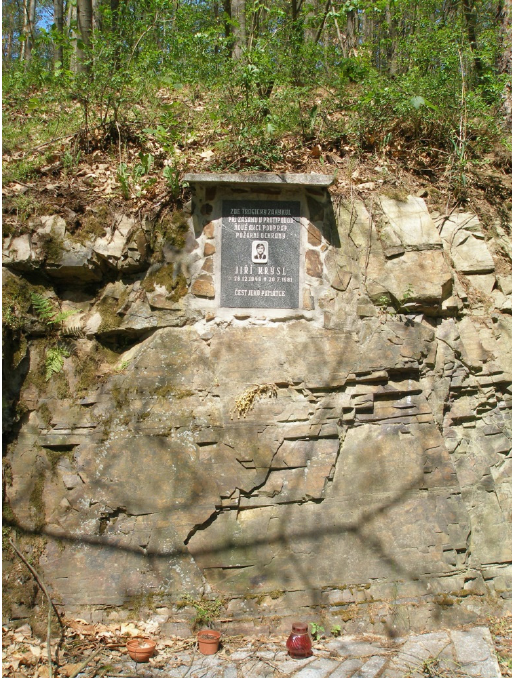
Figure A2. Memorial plaque of Ji ř í Krýsl who died on 20 July 1981 in the valley at Velká Le č ice during a response to flooding (Photo Miloš Hlávka, available under CC BY-SA 3.0 at [99]).